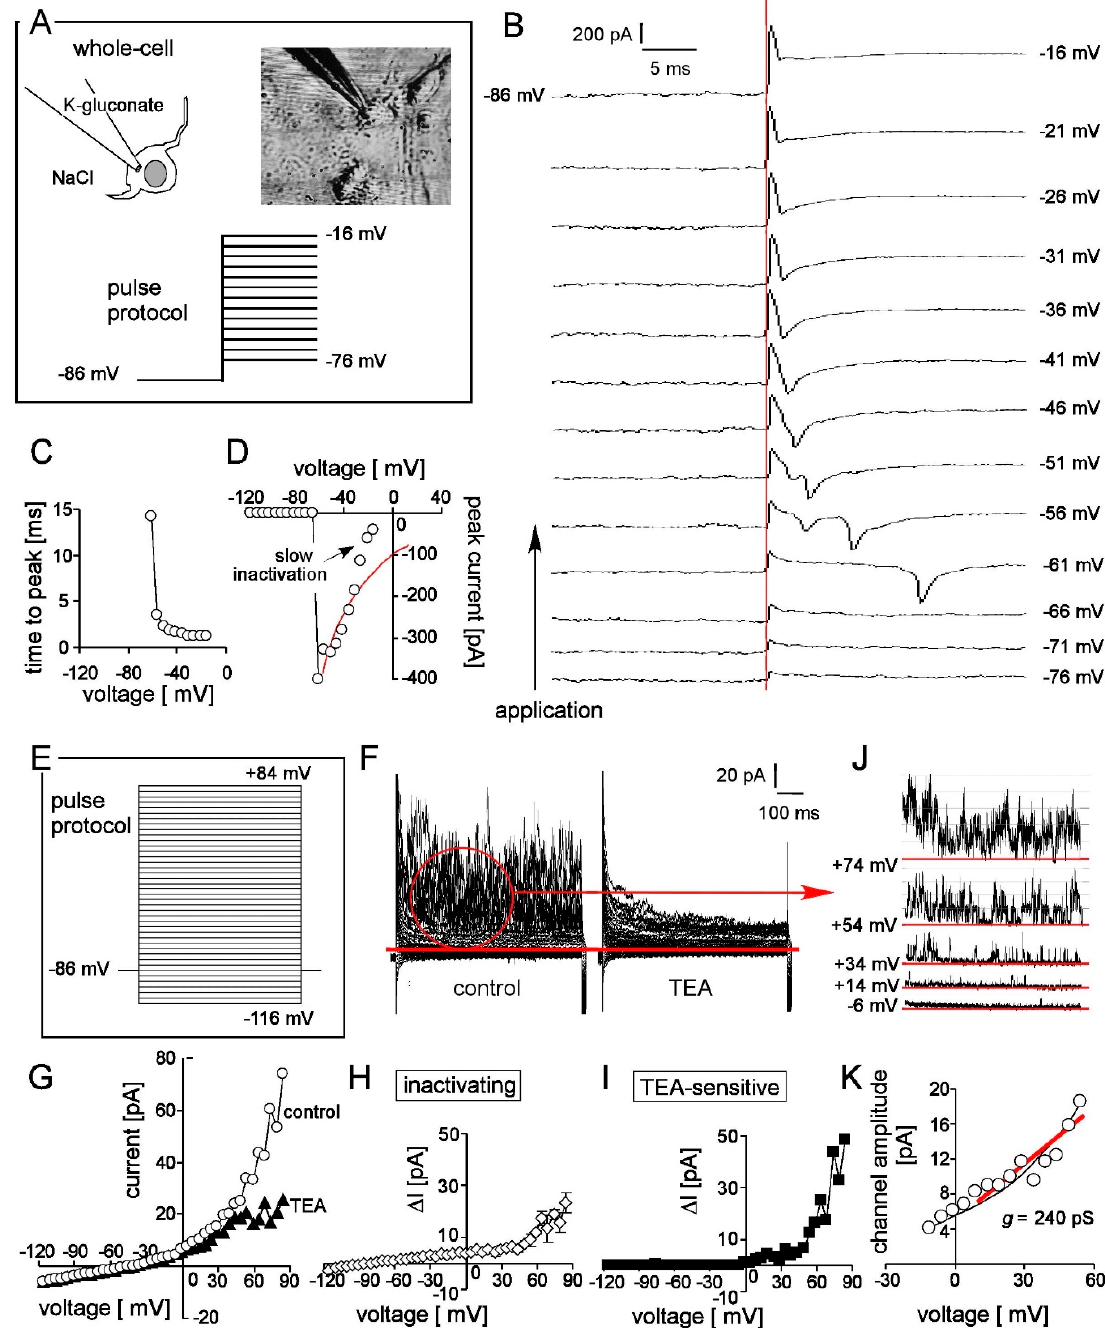
Figure 4. Patch clamp recording of Na v , K v and BK channels in stem cell-derived enteric neurons. Experimental settings of whole cell recording ( A ), current tracings ( B ), voltage dependence of time-to-peak ( C ) and peak current amplitude ( D ) of Na v channels. Applied pulse protocol ( E ), original current tracings ( F ) and current voltage relationship of K + -selective whole-cell currents recorded before (( F ), left and ( G ), open circles) and during bath application of the K + channel inhibitor tetraethylammonium (TEA, 3 mM, ( F ), right and ( G ), closed triangles). ( H , I ) Voltage dependence of the TEA-sensitive ( H ) and the time-dependent inactivating ( I ) current fractions. ( J , K ) Current tracings ( J ) and voltage dependence ( K ) of the unitary current transitions that underlie the TEA-sensitive K + current. The red line in ( D ) indicates the theoretical current-voltage relationship of Na v channels.